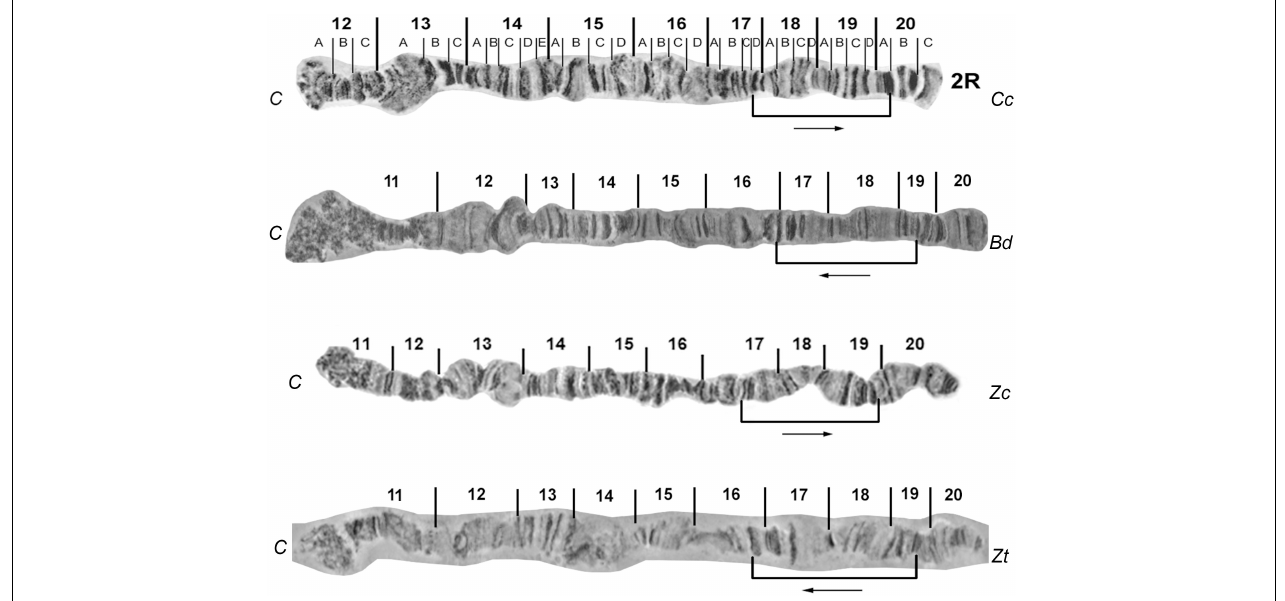
FIGURE 4 | Banding pattern comparison between 2R reference maps of Zeugodacus tau (Zt) with Ceratitis capitata ( Cc ), Bactrocera dorsalis ( Bd ), and Zeugodacus cucurbitae ( Zc ). Characteristic sections and their relative orientation are indicated. 2R of Cc and Zc modified from Figure 6 of: Zacharopoulou et al. (2011b), and 2R of Bd modified from Figure 5 of: Augustinos et al. (2014).